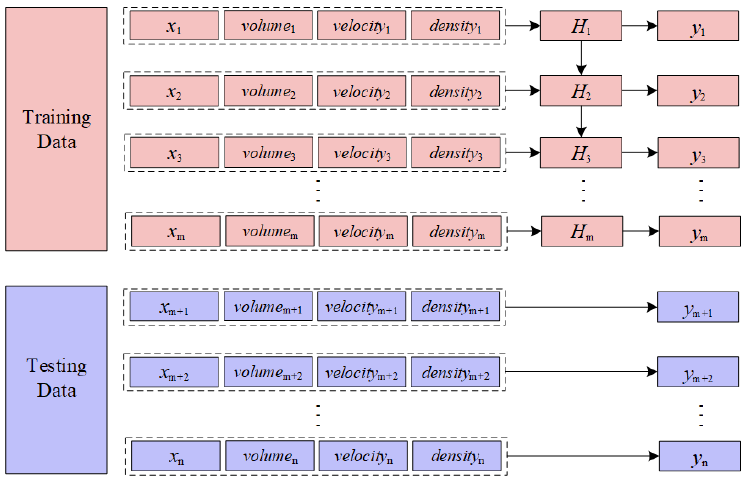
Figure 9. LSTM model with traffic